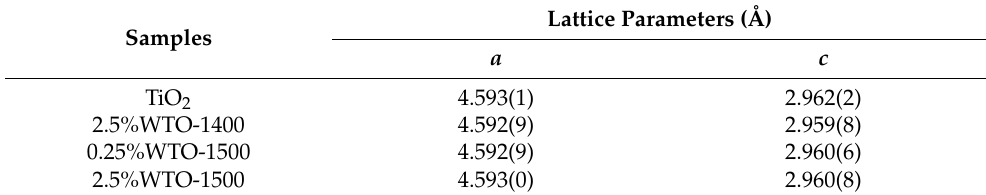
Figure 1. XRD patterns of TiO 2 and WTO ceramics. Table 1. Lattice parameters ( a and c ) of WTO